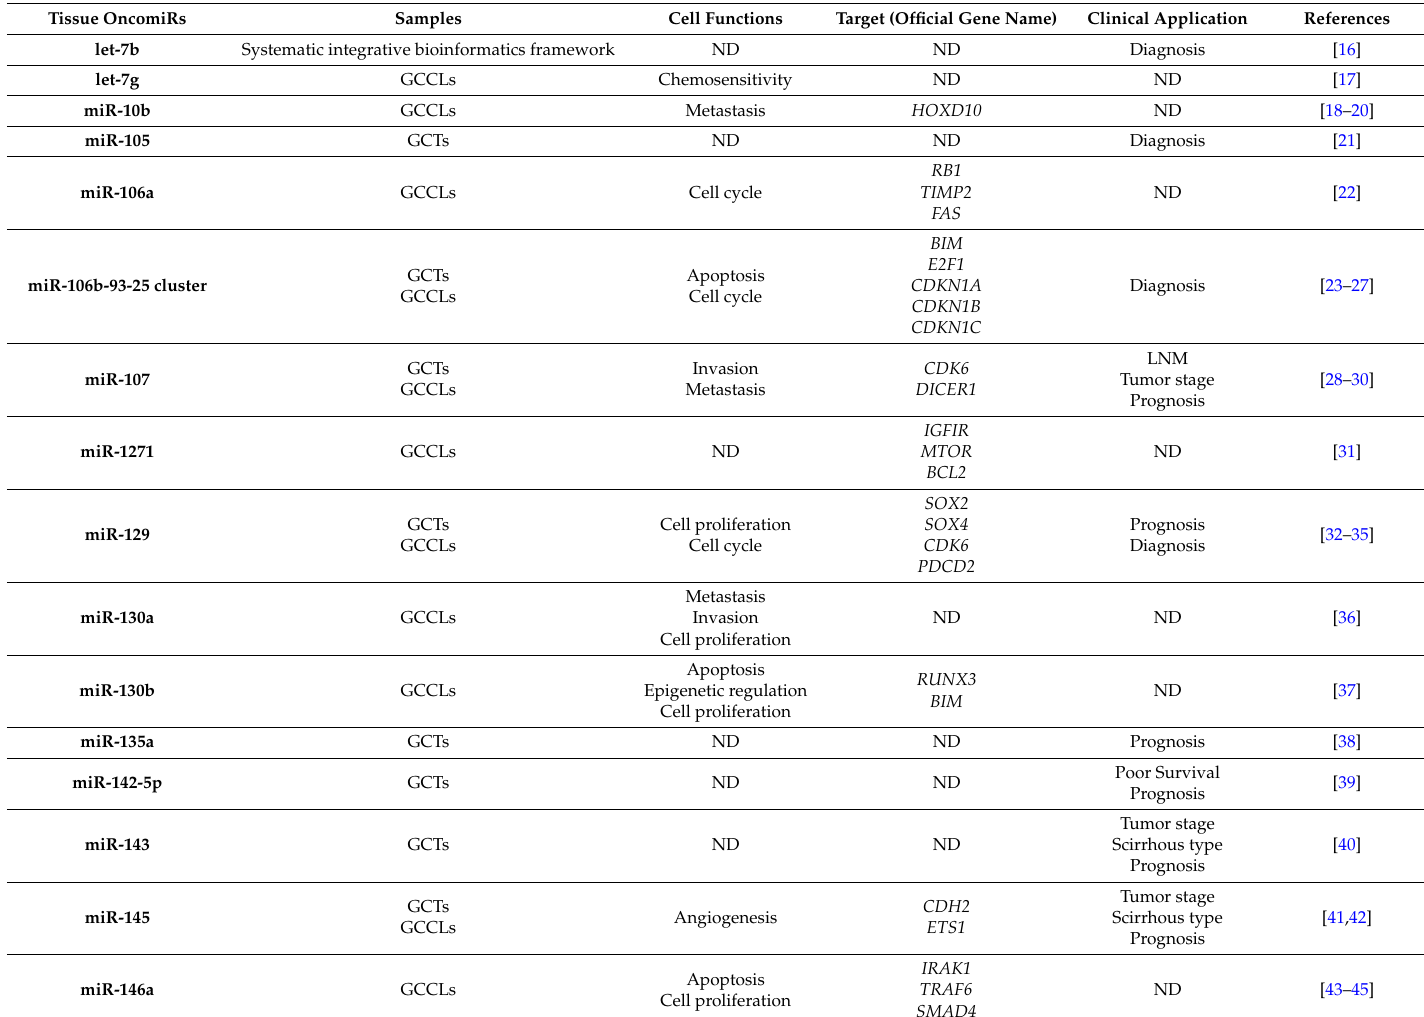
Table 1. Up-regulated miRNAs in tissues for